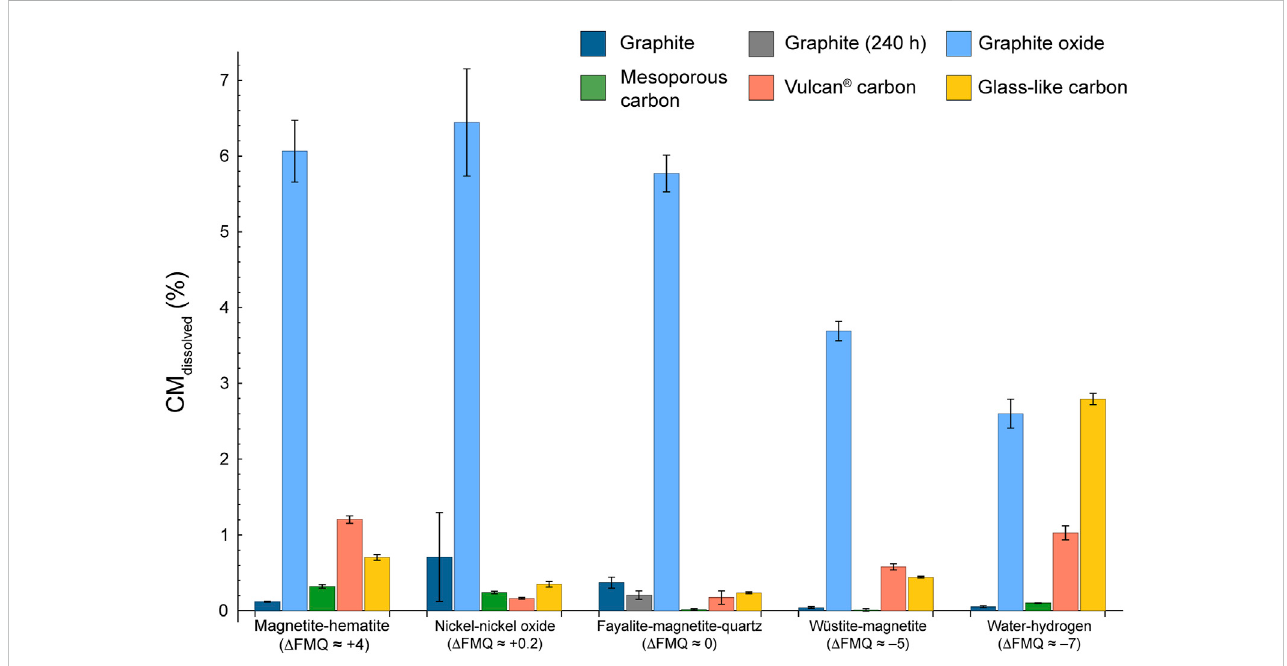
FIGURE 3 CM dissolved in relation to the redox buffer. See the text for the calculation and Table 4 for the data used to produce the fi gure.